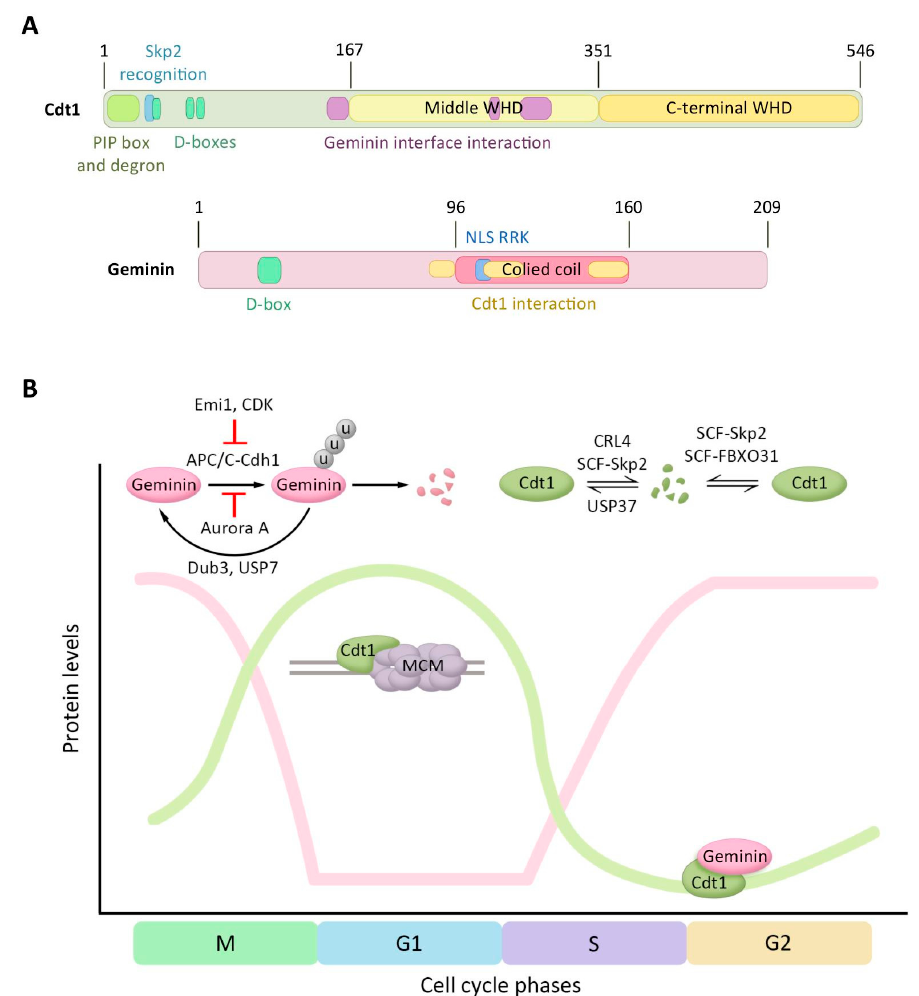
Figure 2. Regulation of Cdt1 and Geminin protein levels by ubiquitination-mediated degradation. ( A ) Domain structure of human Cdt1 and human Geminin. For Cdt1, the regulation motifs of the N-terminal domain (PIP box, Cdt2-recognizing degron motifs, the Skp2 recognition site, and the three destruction boxes), the middle winged helix domain (WHD), the C-terminal WHD, and the region interacting with Geminin are represented. Geminin structure contains a destruction box, a coiled-coil domain, a Cdt1 interacting region, and a nuclear localization signal (NLS). ( B ) Diagram presenting Cdt1 and Geminin protein levels, and its regulators, during the cell cycle. The y-axis presents the levels of the two proteins and the x-axis the progression through the cell cycle. The ubiquitin ligases